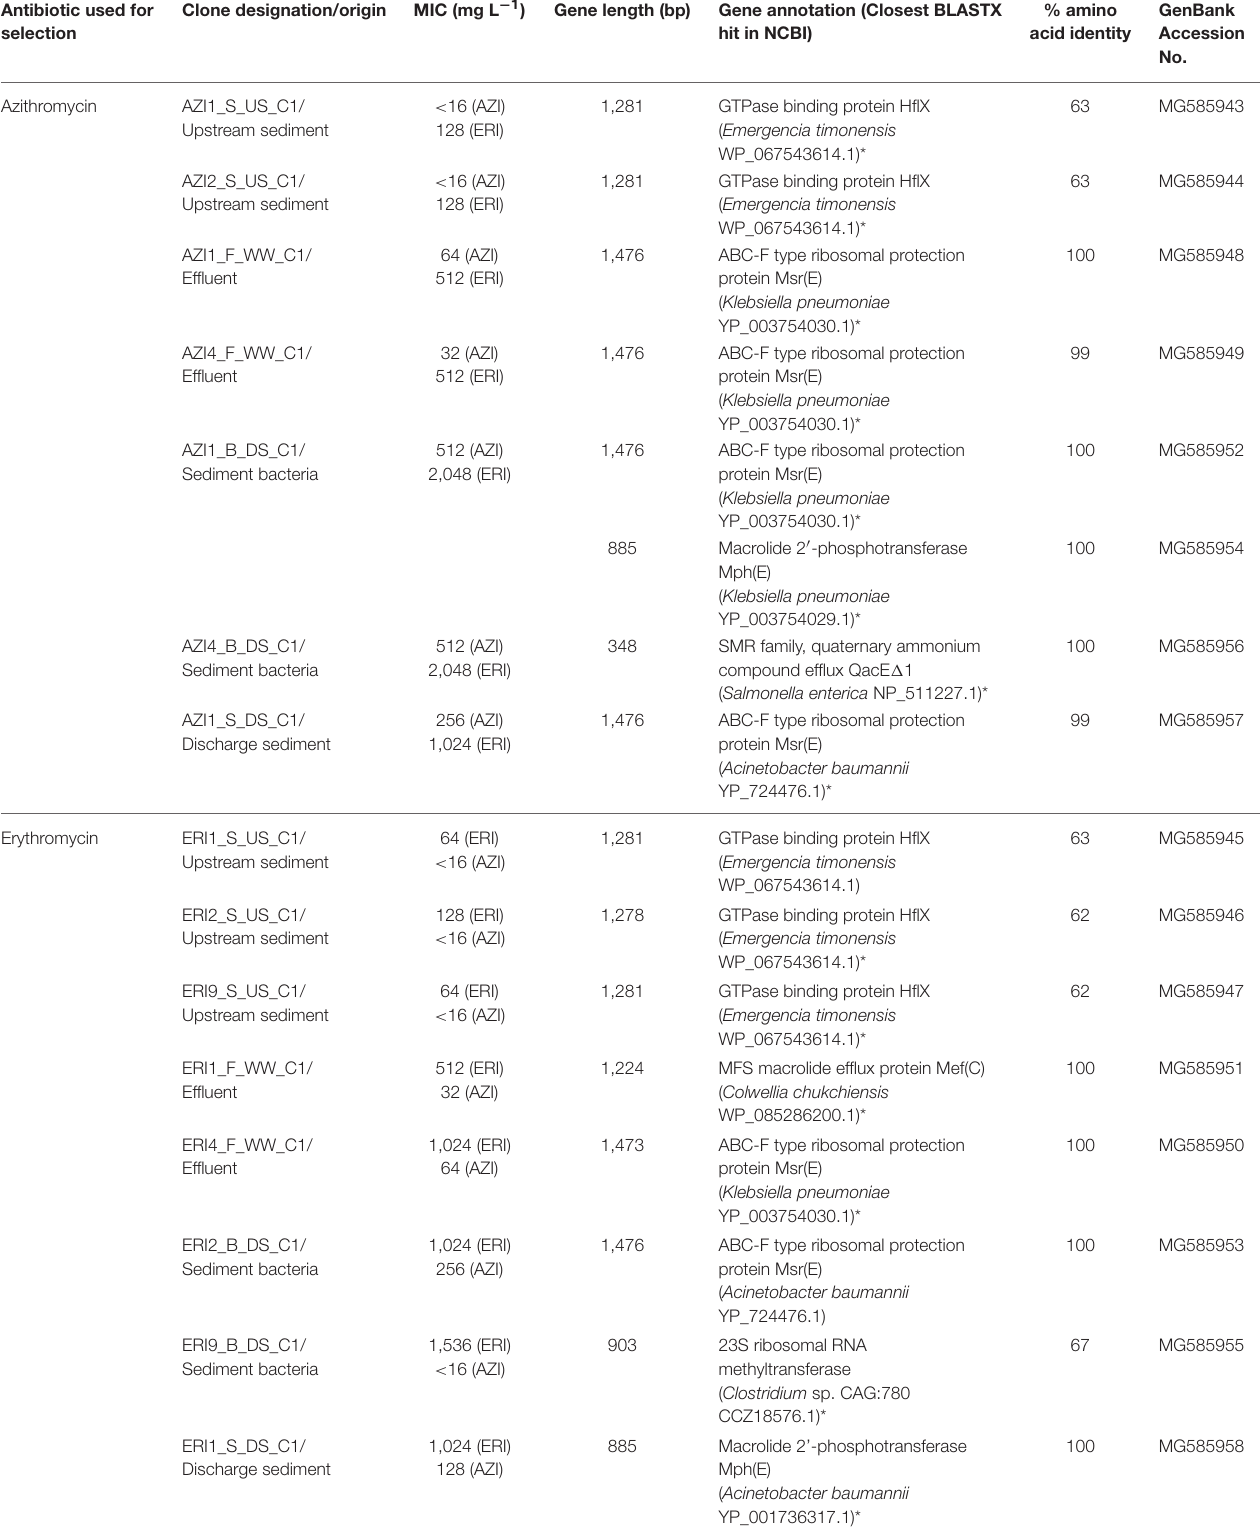
TABLE 2 | Summary of all macrolide resistance genes from clones with distinct restriction digest patterns in functional metagenomic libraries built from effluent and sediments of Industry area 1. Antibiotic used for